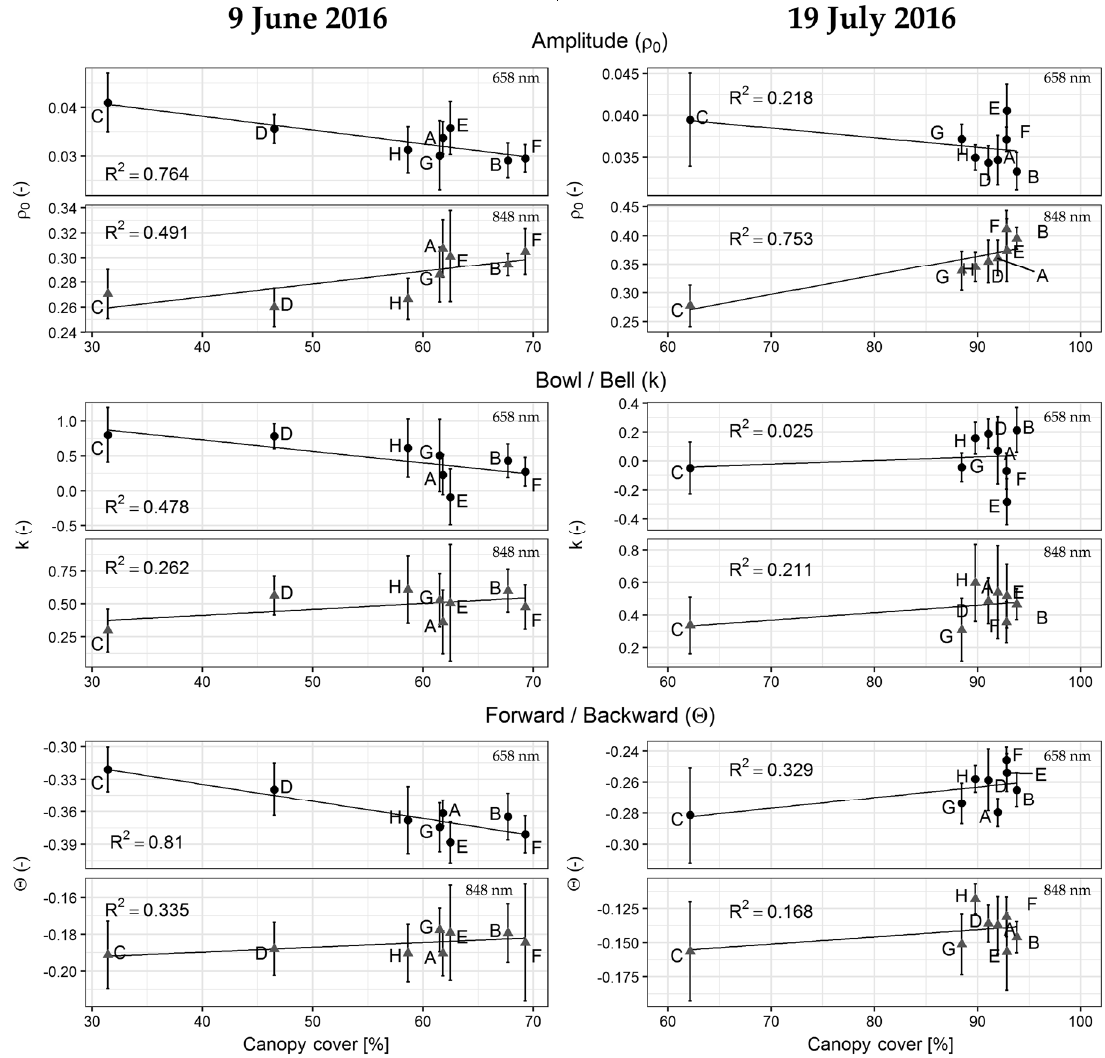
Figure 10. The relation between the (cid:2025) (cid:2868) , (cid:1863) , and (cid:1990) parameters of the RPV model of all pixels in each experimental plot (indicated by letters A–H) and the canopy cover, at 658 nm (black circles) and 848 nm (gray triangles), respectively, for both dates. The error bars indicate the standard deviation.